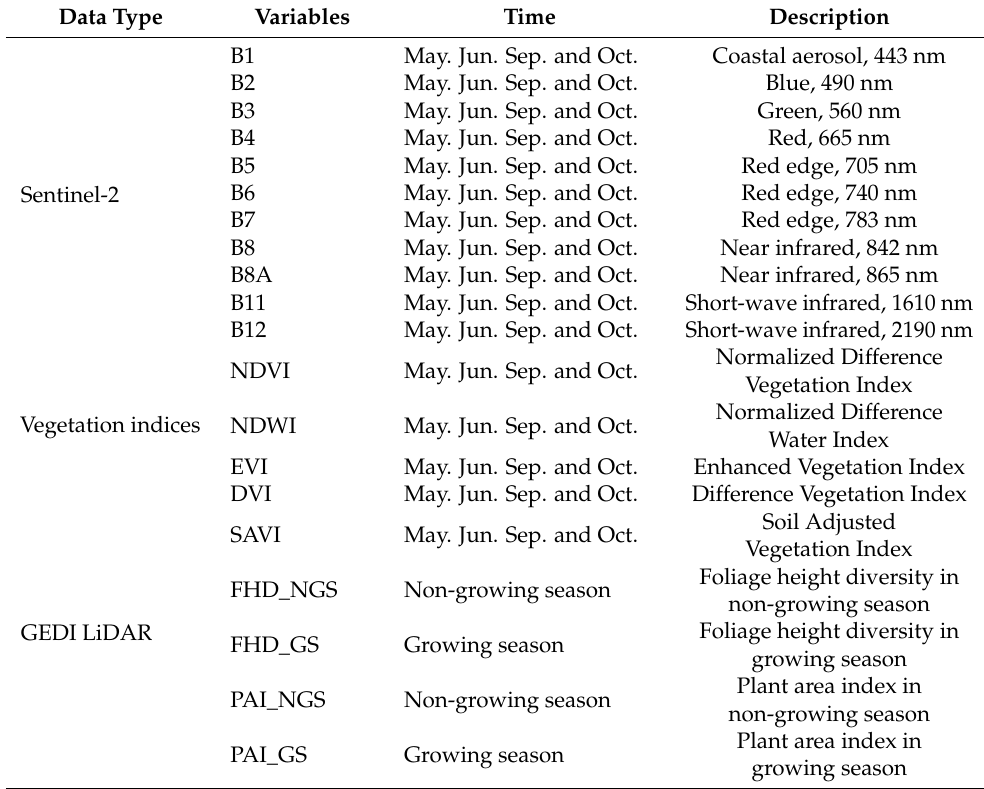
Table 3. Characteristics of data used in this